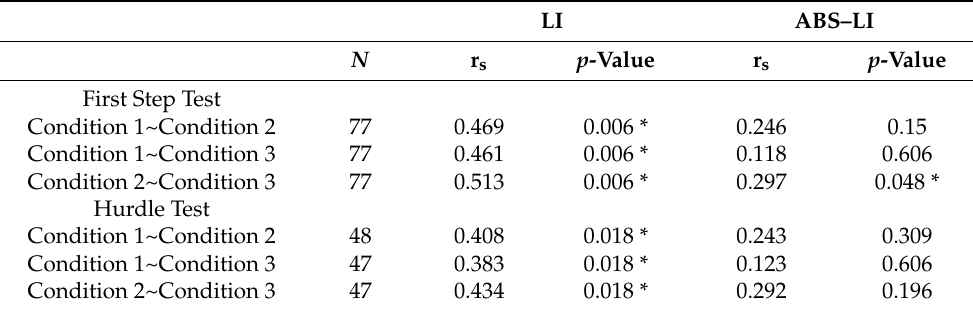
Table 1. Correlations of LI and ABS–LI scores between the different conditions within the First Step or Hurdle Test. Sample sizes ( N ), Spearman’s correlation coefficients (r s ) and Bonferroni-corrected p -values are shown (* p < 0.05).